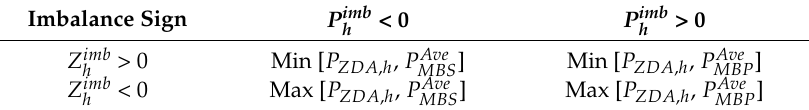
Table 1. Imbalance payments for unit not empowered to participate in the